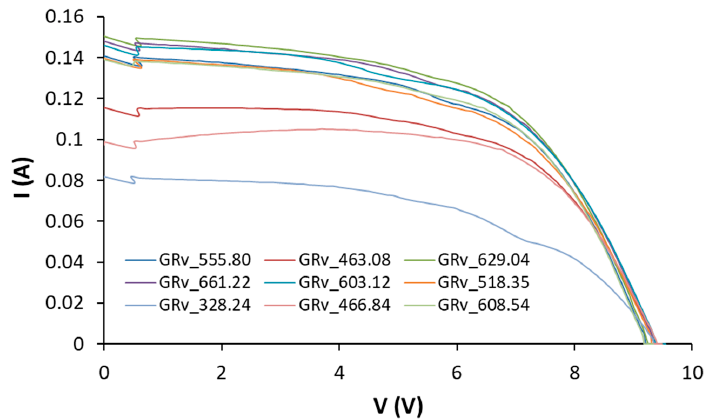
Figure 11. IV curves collected in the central part of the each day of test for DSM. GRv is the vertical global irradiance experienced by DSM.